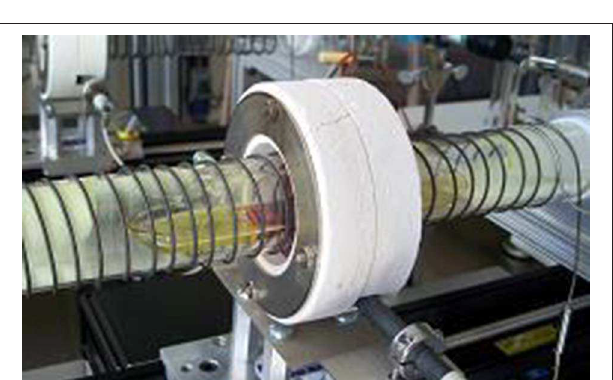
FIGURE 2 | TlBr ingot being purified in a zone refiner.